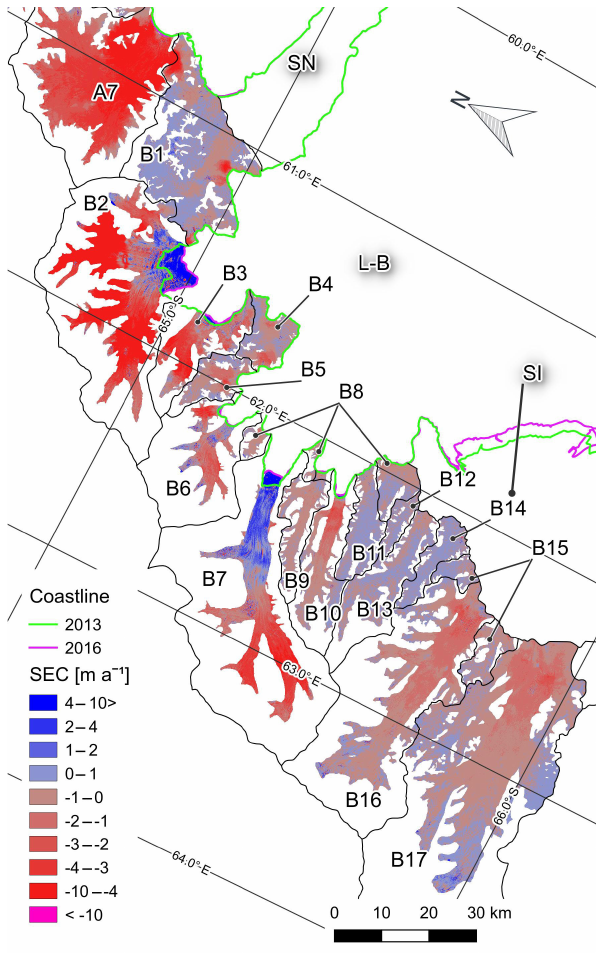
Figure 7. Map of surface elevation change (SEC, ma − 1 ) from June–July 2013 to July–August 2016 on glaciers of the Larsen B embayment (L-B). SN – Seal Nunataks. SI – Scar Inlet ice shelf.